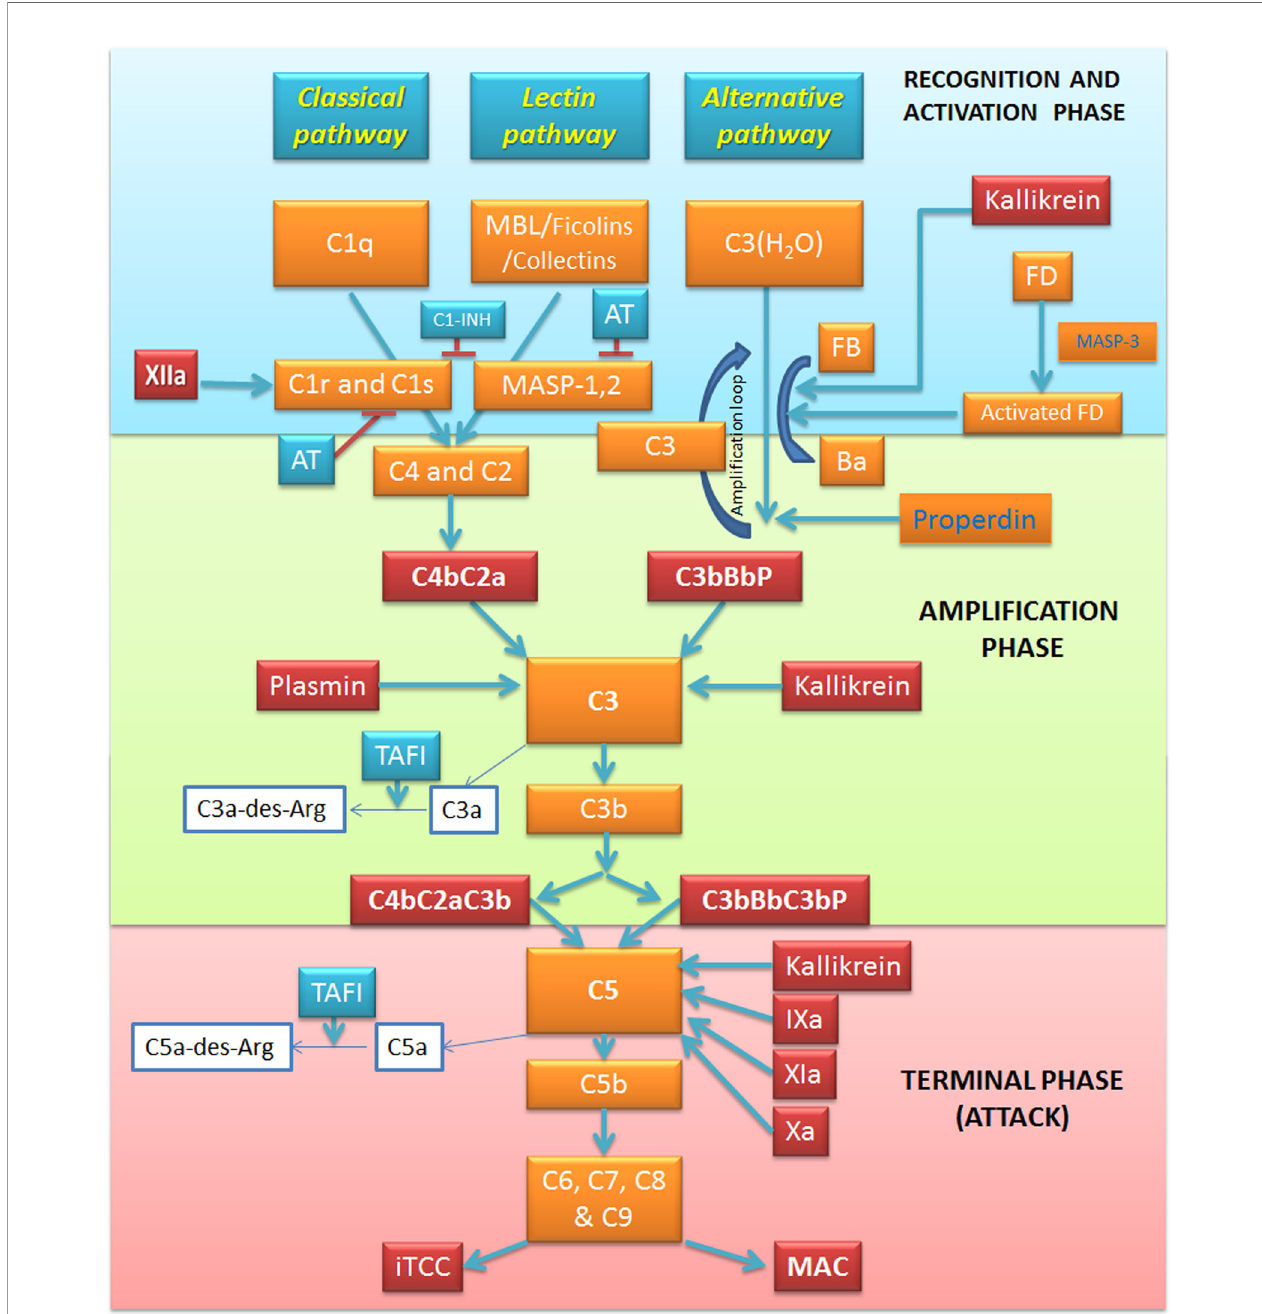
FIGURE 1 | Overview of the complement system (C) and its interplay with the coagulation and kallikrein-kinin pathways. The activation of C via three pathways: classical, alternative and lectin. The recognition and activation phases in each pathway converge on the formation of C3 convertase. The ampli fi cation phase is initiated when the C3 convertase cleaves C3, and C3b attachment to C3 convertases changes their substrate speci fi city, allowing them to become C5 convertase. The C5 convertase cleaves C5, starting the last phase (Terminal-Attack phase), in which C5b forms the membrane-attack complex with C6, C7, C8, and C9, resulting in cell perturbation. Kallikrein exerts its activity on C activation in all these three phases. Factor (F) XIIa activates the classical pathway, whereas plasmin enhances the ampli fi cation loop. Thrombin, FIXa, FXa, FXIa, and kallikrein directly activate C5. AT, Antithrombin; C1-INH, C1-inhibitor; F, Factor; MAC, Membrane attack complex; MASP, MBL associated serine protease; MBL, Mannose binding lectin; iTCC, Inactive terminal complement complex; TAFI, Thrombin activatable fi brinolysis